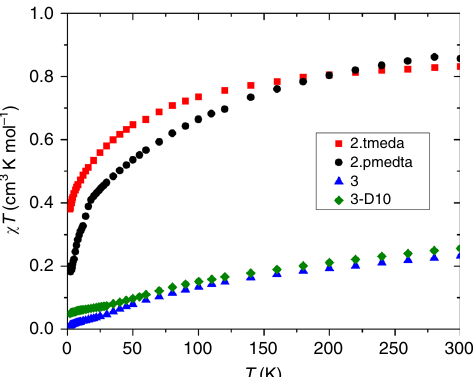
Fig. 6 Temperature-dependent magnetic susceptibility ( χ ) data as χ T ( T ) for the compounds in this study. Trivalent 2 .tmeda = black circles; Trivalent 2 . pmdeta = red squares; Pentavalent dimeric 3 = green triangles; Pentavalent 3 -D 10 = blue triangles. The data were measured in an applied magnetic fi eld of 0.5 kG